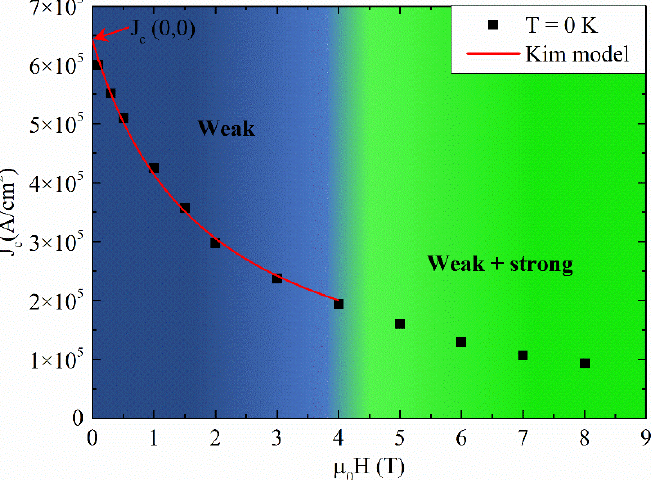
Figure 5. Magnetic field dependence of J c at T = 0 K. The red solid line is the fit of the J c (H) at T = 0 K